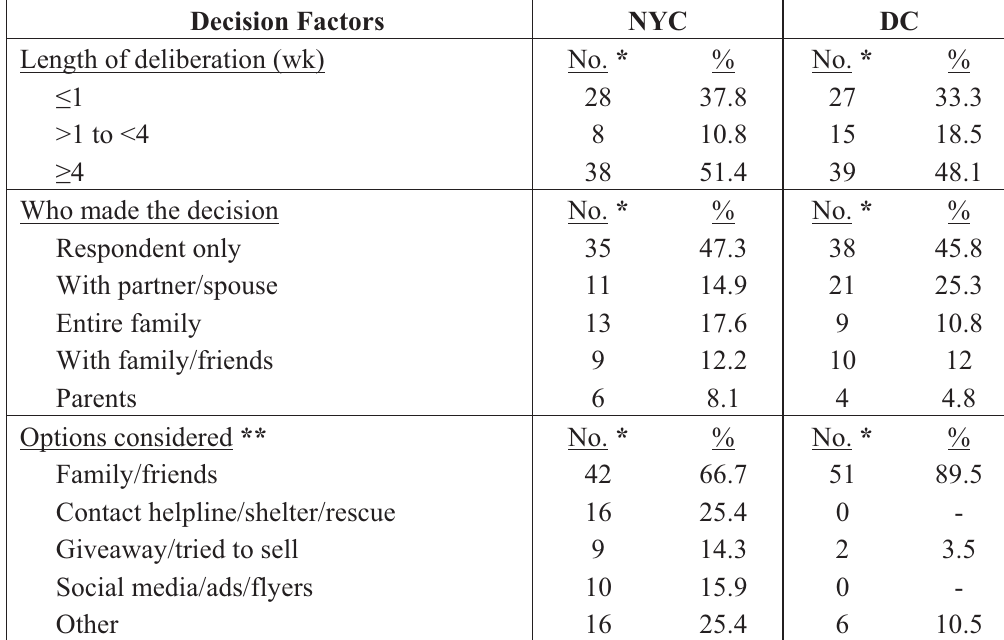
Table 4 . Decision factors considered before the dog was relinquished to a shelter in New York City and Washington,